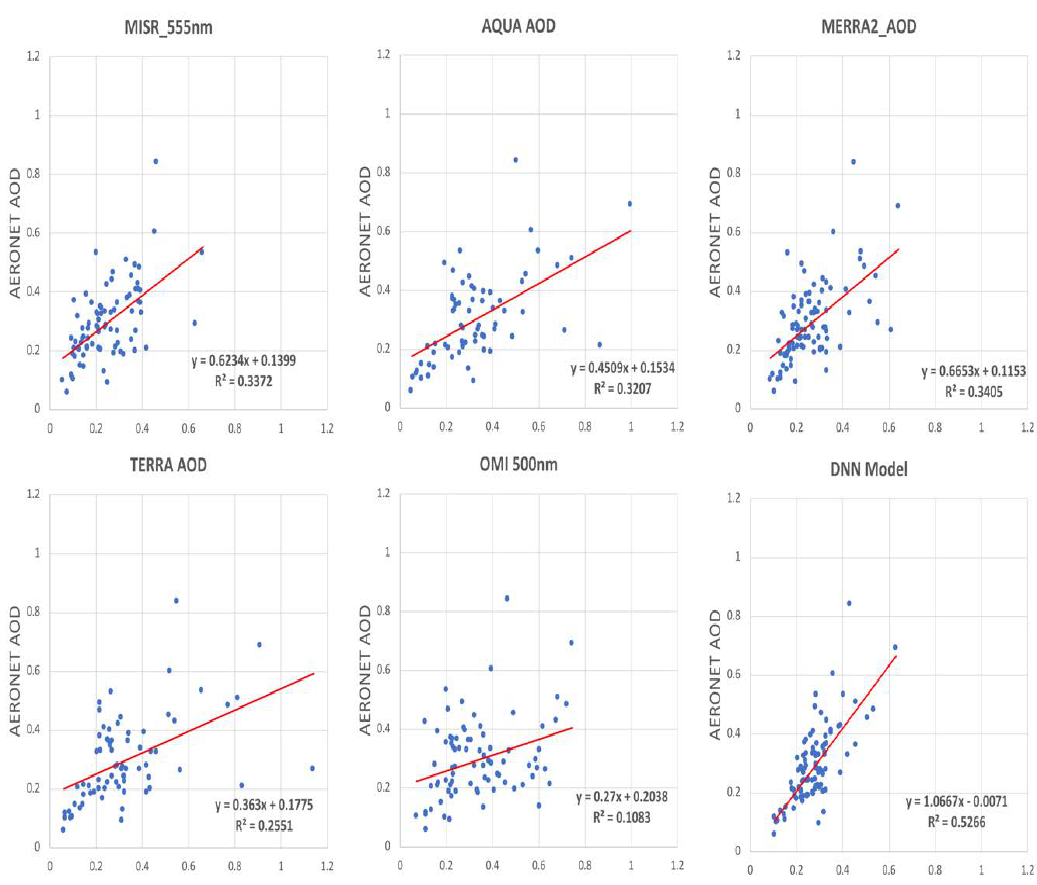
Figure 11. Comparison of DNN model to the other Satellite/Models vs. AERONET for the MENA region countries.